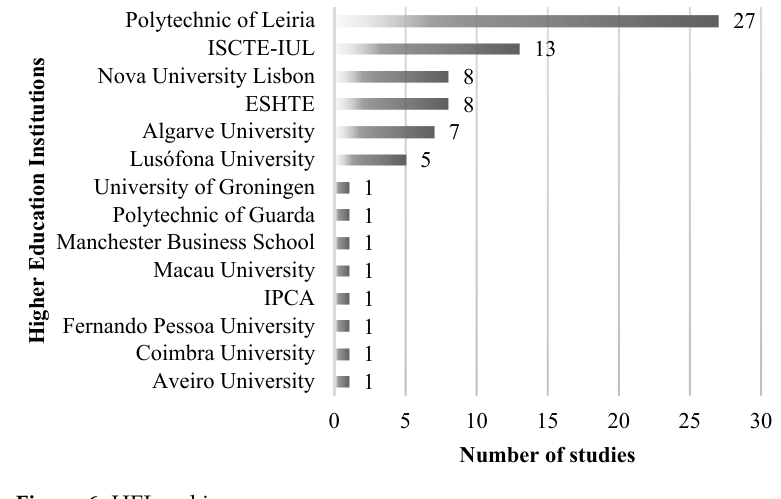
Figure 6. HEI ranking.